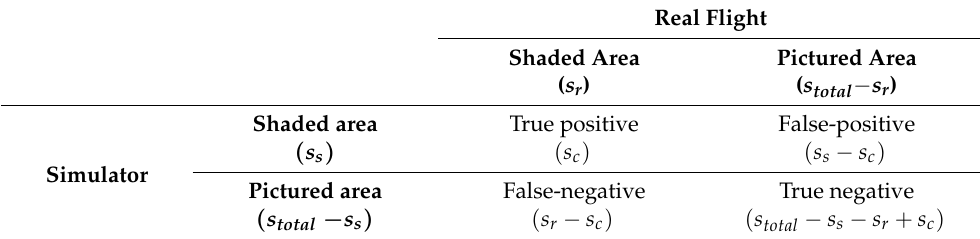
Figure 8. Shaded area relation between simulator and actual flight. Table 3. Comparison between real flight and simulator in the detection of shaded